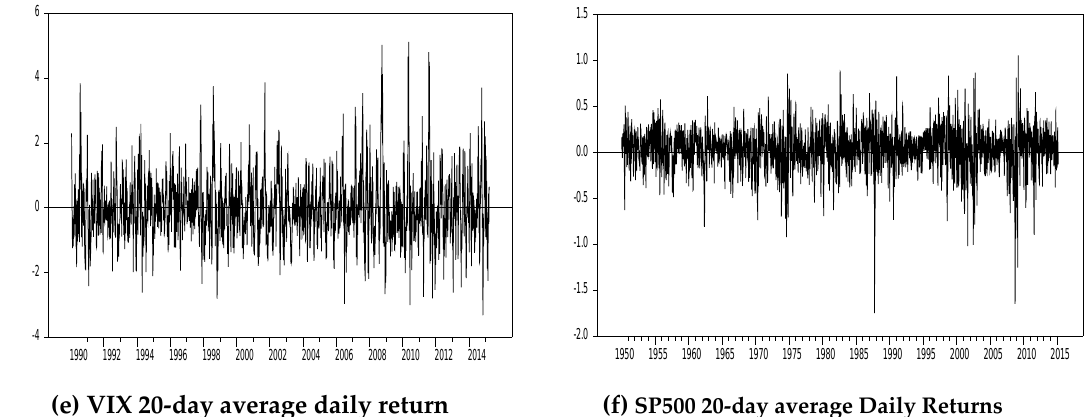
Figure 2. Exogenous Variables: Returns on VIX and S&P 500.